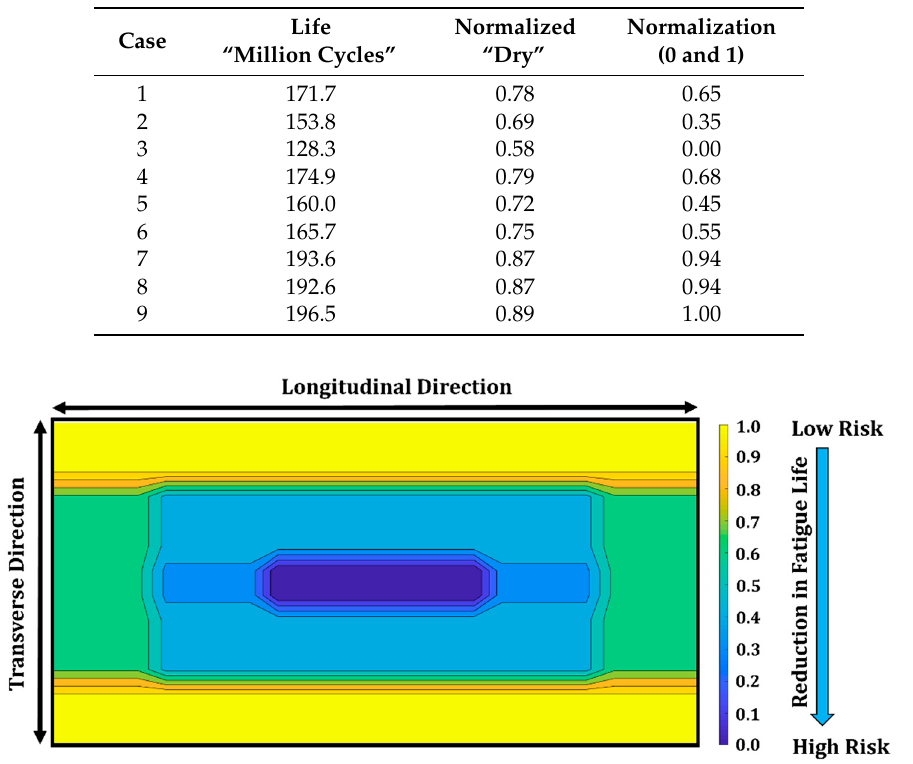
Table 4. Utilized cases for building the hazard map.